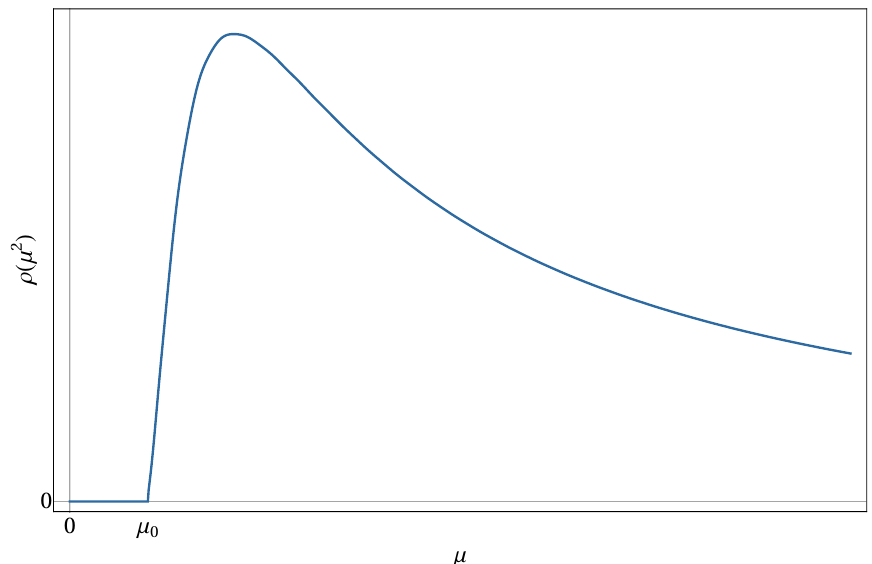
Figure 1 . Cartoon of a gapped continuum spectral density. The spectral density vanishes for µ less than the gap scale µ 0